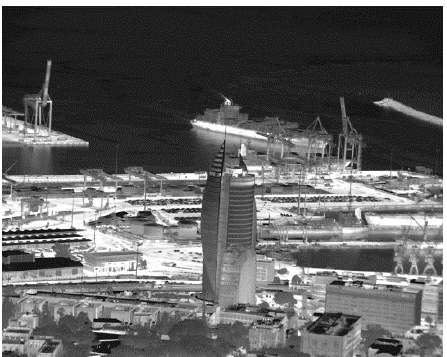
Figure 73. Image taken by 15 μ m HOT Hercules 1280 × 1024, InAs 0.91 Sb 0.09 XBn FPA at f/ 3 optics, and 150 K (after [208]).